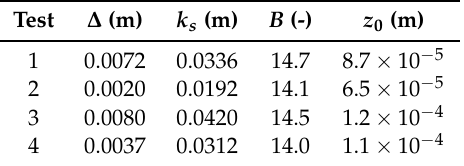
Table 3. Parameters describing the log-law for Scenario 1, where κ = 0.405.